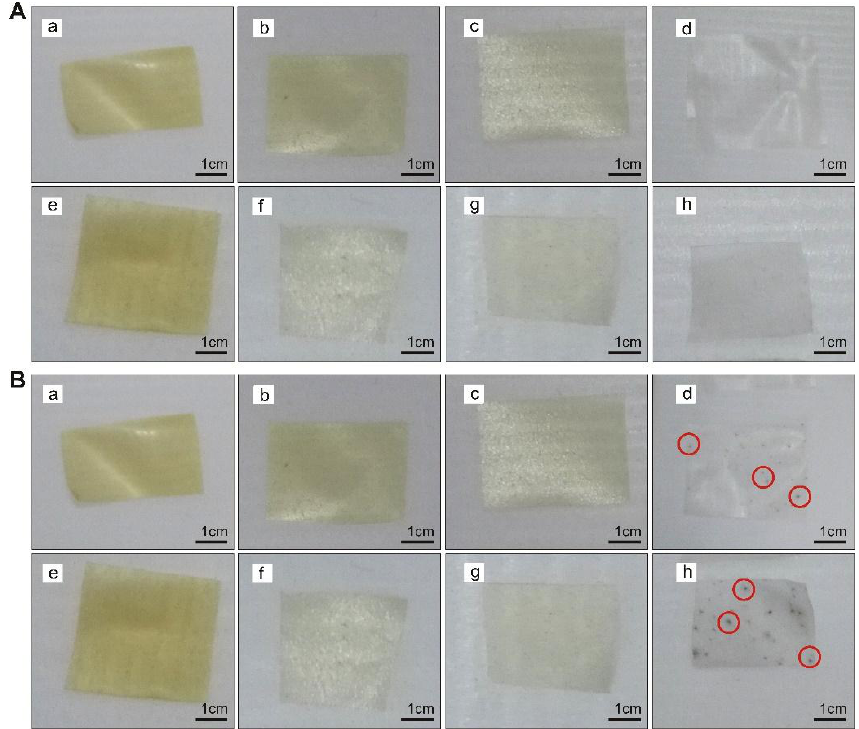
Figure 5. The films ( A ) before and ( B ) after 90-day storage. a, CSF; b, CSMCF1; c, CSMCF2; d, MCF; e, CCSF; f, CCSMCF1; g, CCSMCF2; h, CMCF.